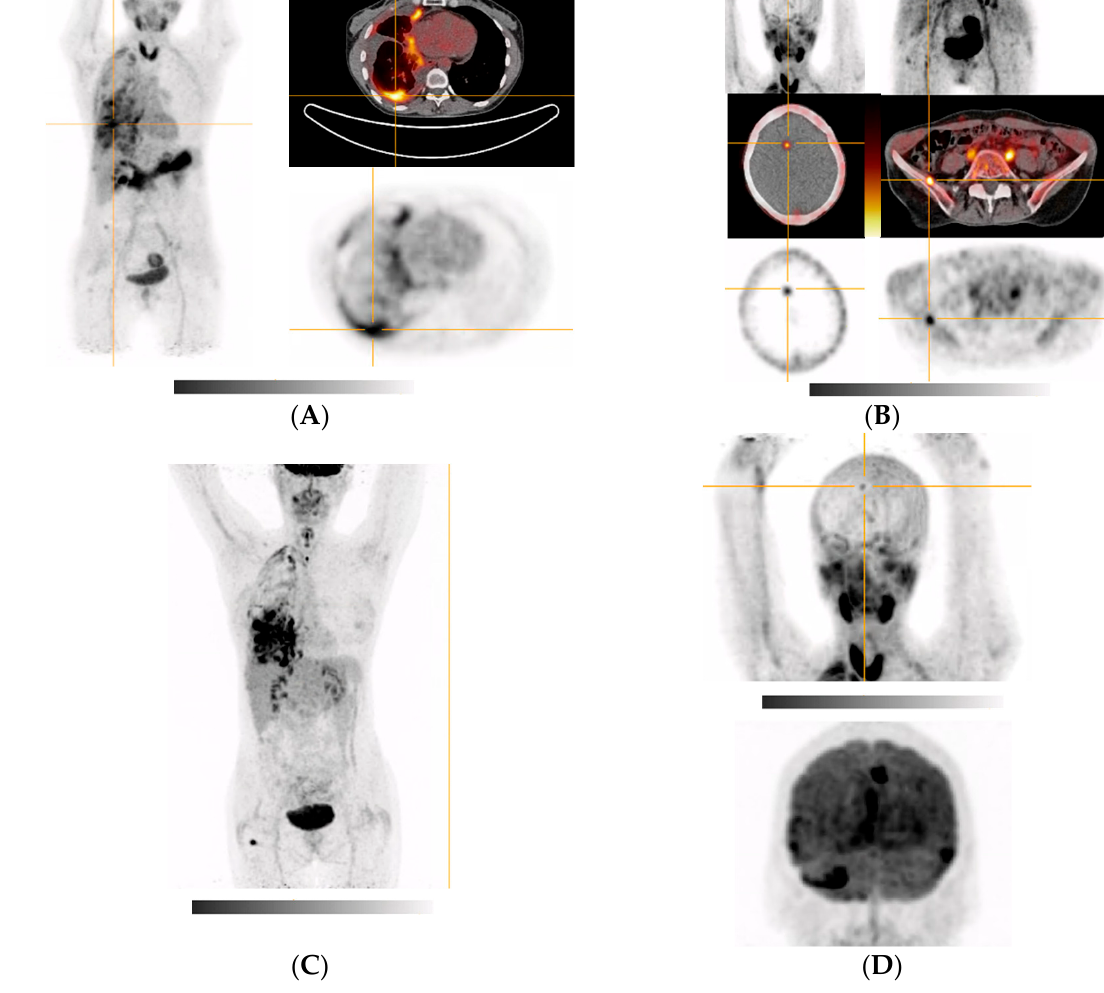
Figure 5. ( A ) MIP and transversal image of [ 68 Ga]Ga-DATA 5m .SA.FAPi in a NSCLC patient. Crosshair indicates target lesion with a SUV max of 7.3. ( B ) Cerebral ( left ) and bone ( right ) metastases demonstrated by FAPI-PET/CT. ( C ) and ( D ) MIPs, FDG scan performed two weeks before imaging with [ 68 Ga]Ga-DATA 5m .SA.FAPi; the upper picture in ( D ) is the enlarged image of the head shown in ( B ).